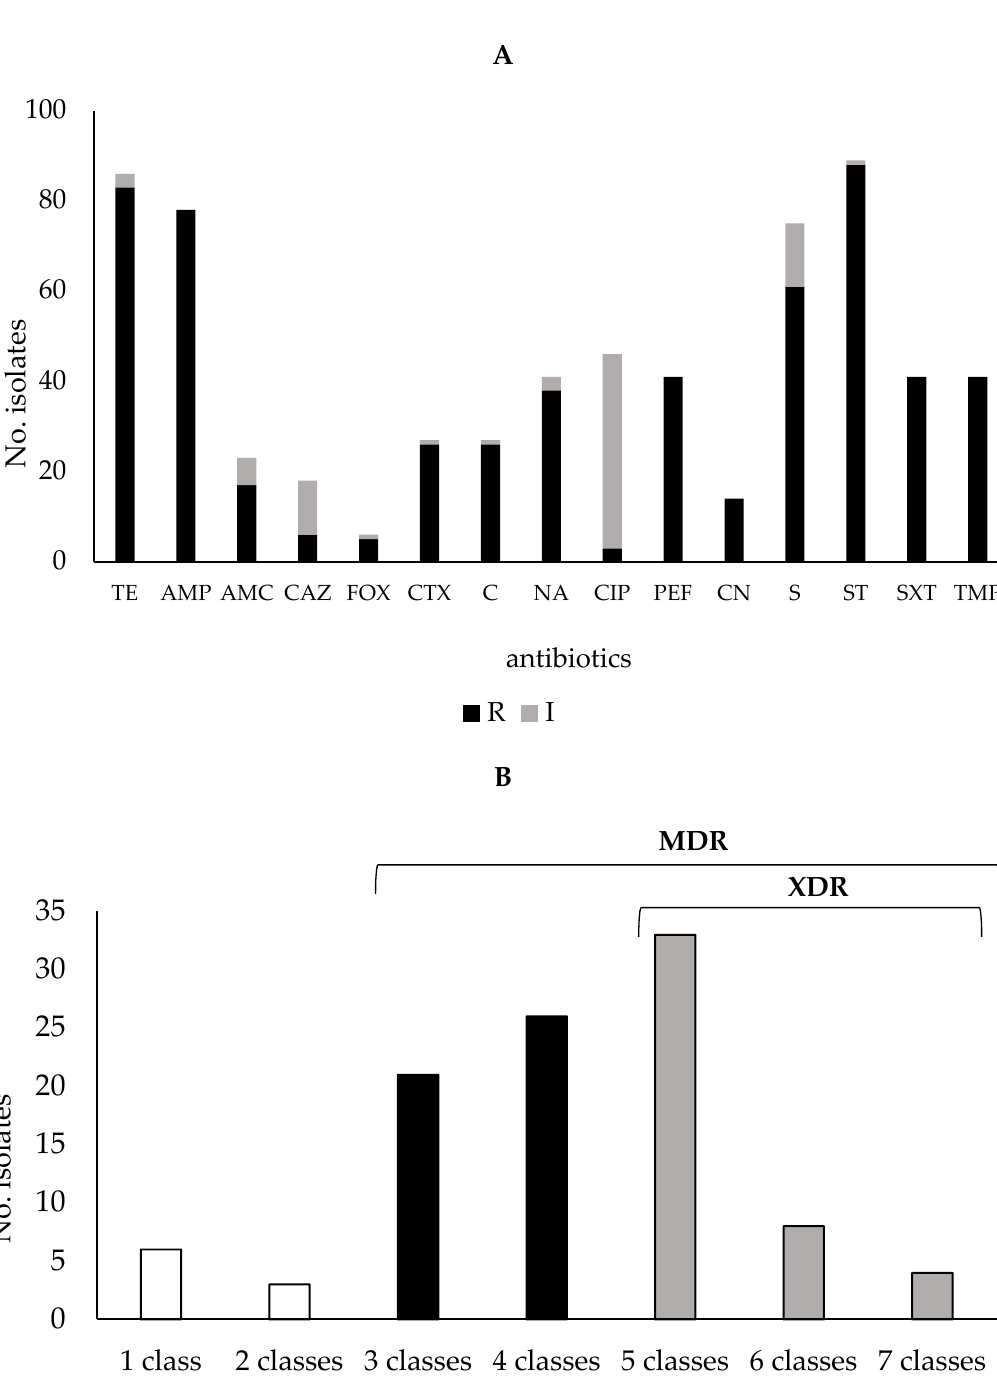
Figure 1. Resistance rate of Salmonella strains analysed in this study. ( A ) Strains were resistant to one or more antibiotic classes, and the major resistance was detected against sulfisoxazole and tetracycline. R: resistant (black), and I: intermediate (grey) resistant strains. AMP, ampicillin; CTX, cefotaxime; CAZ, ceftazidime; AMC, amoxicillin+clavulanic acid; FOX, cefoxitin; TE, tetracycline; C, chloramphenicol; CIP, ciprofloxacin; NA, nalidixic acid; PEF, pefloxacin; CN, gentamicin; S, streptomycin; SXT, trimethoprim-sulfamethoxazole; ST, sulfisoxazole; TMP, trimethoprim. ( B ) Distribution of Multi-and Extensively Drug-Resistant Salmonella strains. The major part of strains were resistant to three or more antibiotic classes (multidrug-resistant; MDR) whereas 44% were resistant to at least one agent in all but two or fewer antimicrobial categories (extensively drug-resistant; XDR) ( B ).